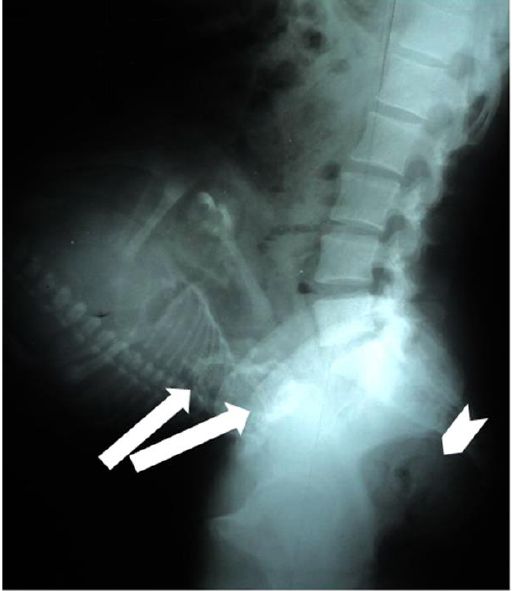
Figure 2. Foetal X Ray in lateral view. White arraows indicate the mandible and facial bones. Arrowhead indicates the foetal brain occupying the true pelvis of the